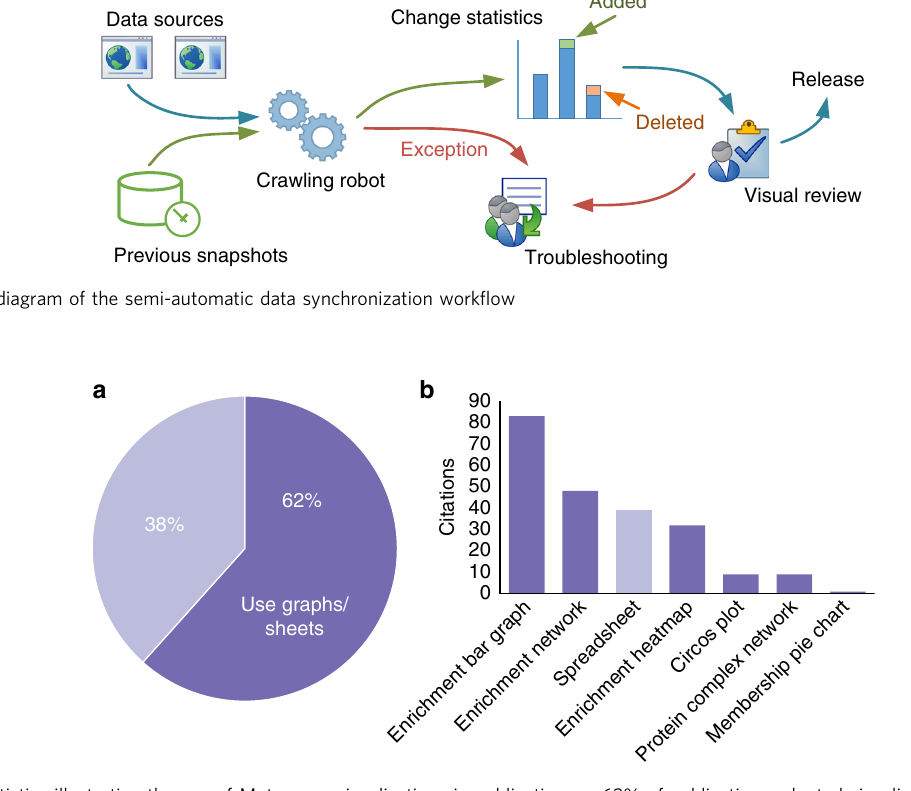
Fig. 5 Citation statistics illustrating the use of Metascape visualizations in publications. a 62% of publications adopted visualizations prepared by Metascape. b Visualization types sorted according to their popularity, where the enrichment bar graph, network, and heatmap are frequently used to summarize functional enrichment